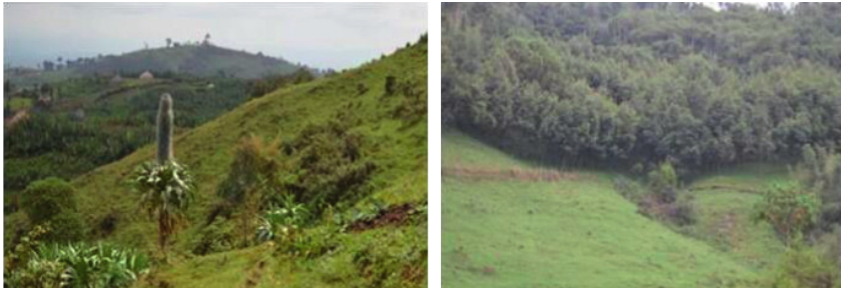
Figure 4: Modified dry evergreen Afromontane forest habitat at Geremba Mountain (photo: Zerubabel Worku,